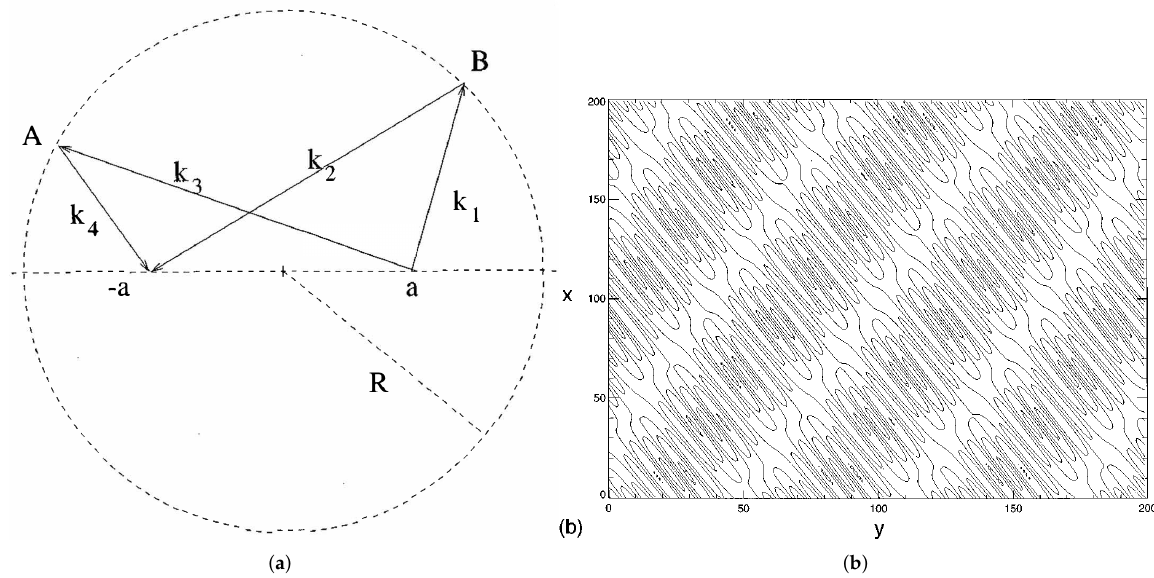
Figure 10. ( a ) A set of four two-dimensional vectors k 1,2,3,4 which solves equations (137). Here, A and B are two arbitrary points belonging to the circumference of arbitrary radius R , and a < R is an arbitrary value of coordinate x . ( b ) An example of the three-dimensional quasiperiodic pattern, projected onto the ( x , y ) plane. Shown are contour plots of the (cid:104) (cid:105) ∑ 4 u l cos ( k l · R ) corresponding distribution of the order parameter, Re , where u l are the complex amplitudes given by l = 1 Equations (141)–(143). In this case, the phases are ϕ 1 = π , ϕ 2 = − π /2, ϕ 3 = π /7, while ϕ 4 is determined by Equation (142). The angle between vectors k 1 − k 2 and k 3 − k 4 is π /5. Figure is reprinted with permissions from Ref.